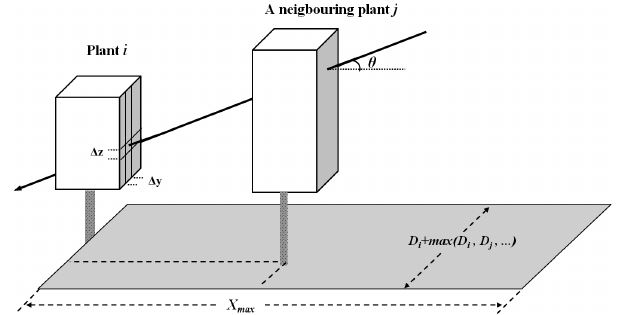
Figure 4. The scheme of the random approach for numerically cal- culating sunlit leaf area and the shading effects of the neighbouring plants. max( D i ,D j ,... ) is for the maximum of the crown width of all the plant strata in the plant community.